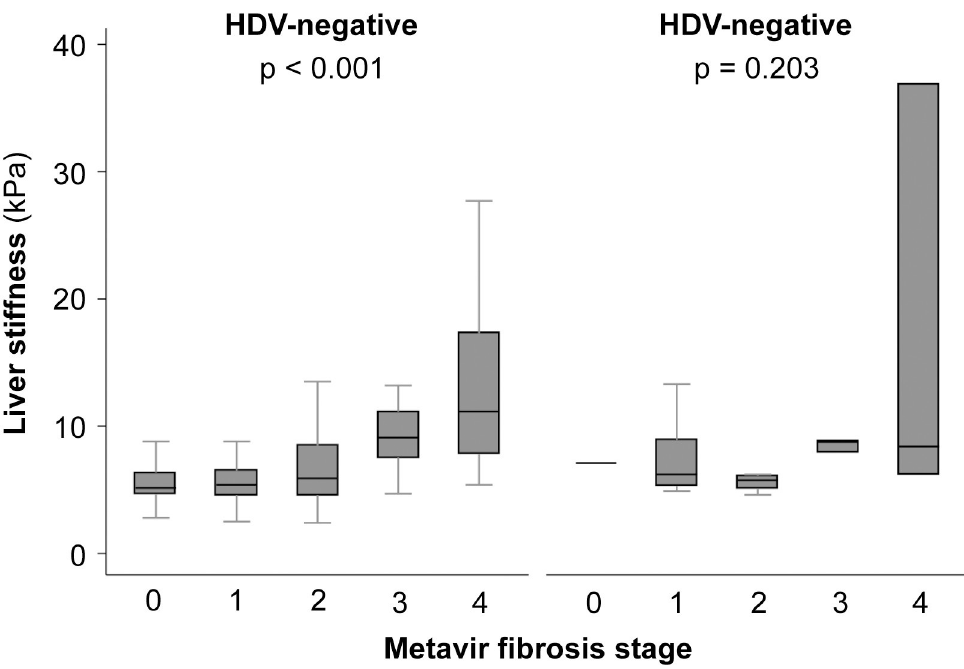
Fig 1. Correlation between liver stiffness as evaluated by transient elastography and histological fibrosis stage according to the absence or presence of hepatitis D virus (HDV) coinfection. The horizontal line within each box represents the median, the limits of each box the interquartile range, and the whiskers the maximum and minimum values. Statistical analyses were performed using Kruskal-Wallis test and p values calculated comparing liver stiffness and Metavir fibrosis stage.